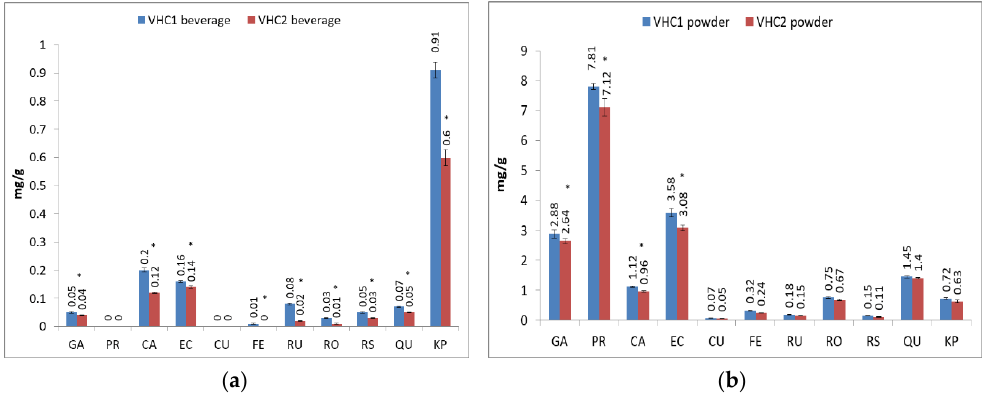
Figure 1. Individual polyphenols in final products vegan hot chocolate 1 (VHC1) and vegan hot chocolate 2 (VHC2) as beverages ( a ) and powders ( b ) (mg/g), respectively. * superscript between final products indicate significant differences ( p < 0.05) between values according to the T